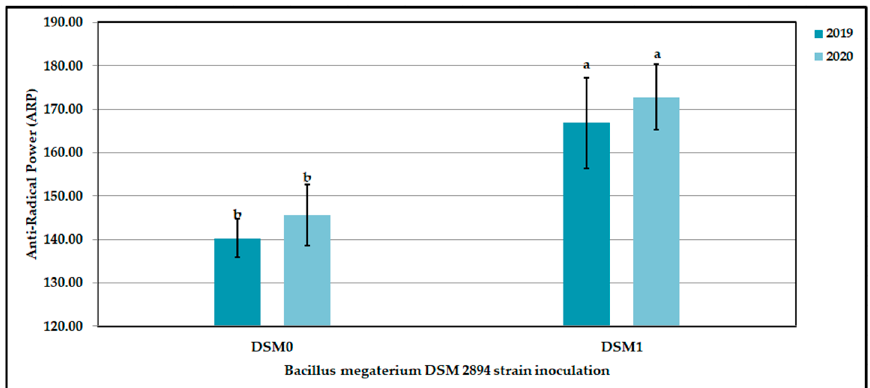
Figure 18. Influence of calcium superphosphate levels (CSP) on protein content of CaCO 3 ‐ stressed sweet potato plants grown in 2019 and 2020 seasons. Bars with a different letter indicate significant different between treatments at p ≤ 0.05. CSP 20 , CSP 40 , CSP 60 , CSP 80 , and CSP 100 represent CSP added as a soil application at 69, 138, 207, 276, and 345 kg ha − 1 , respectively.